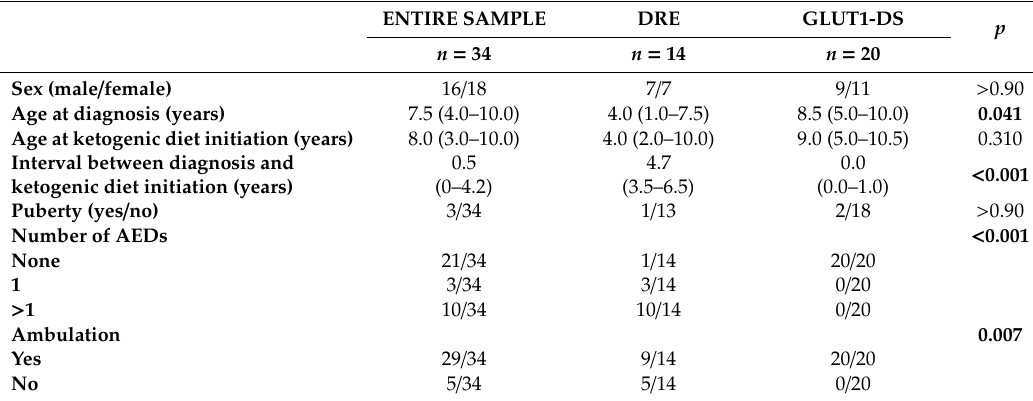
Table 1. Baseline characteristic of the entire sample and of DRE and GLUT1-DS patients.